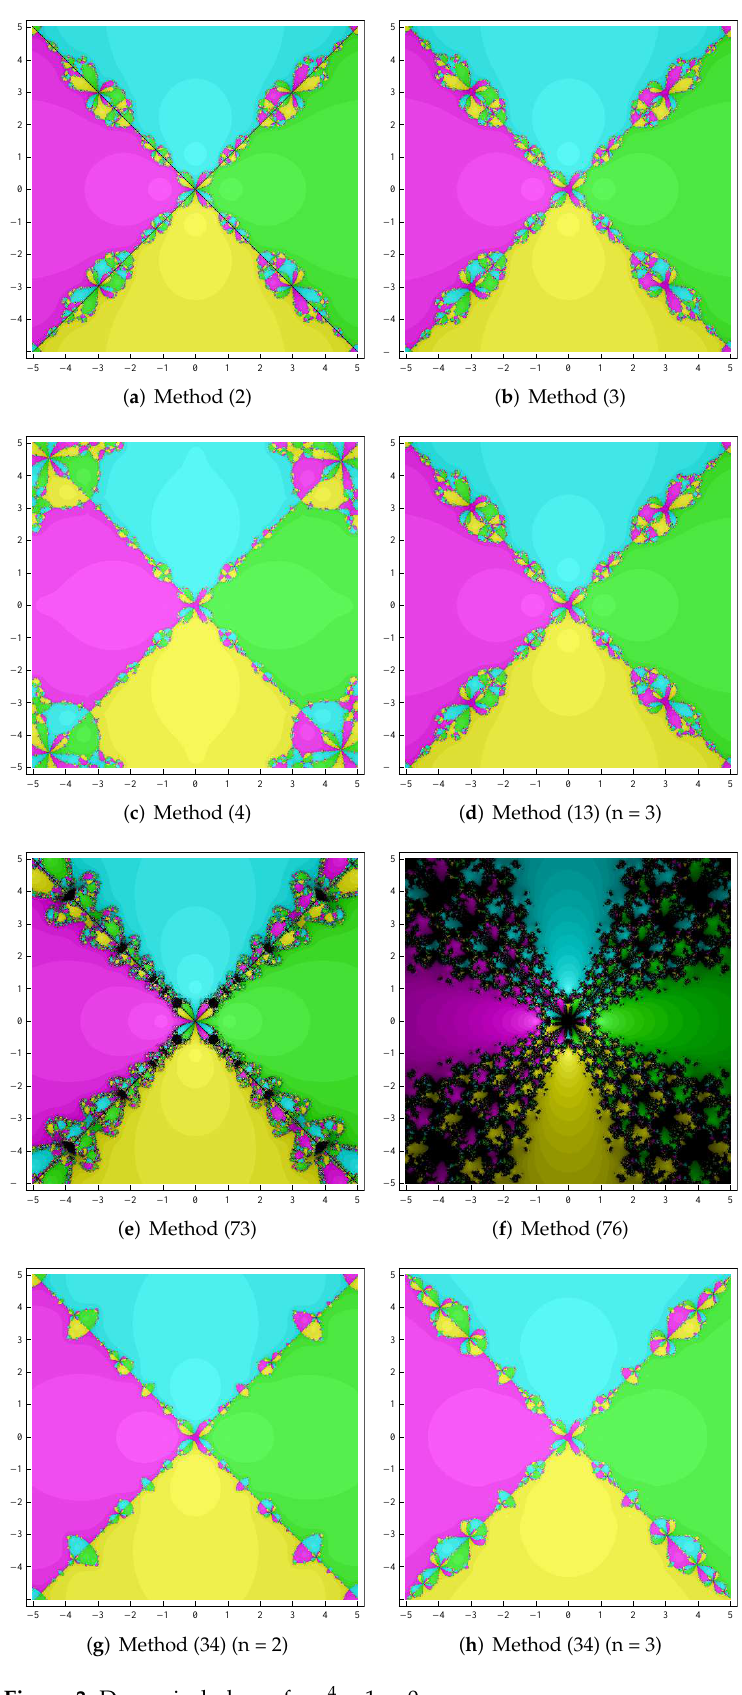
Figure 3. Dynamical planes for z 4 − 1 =